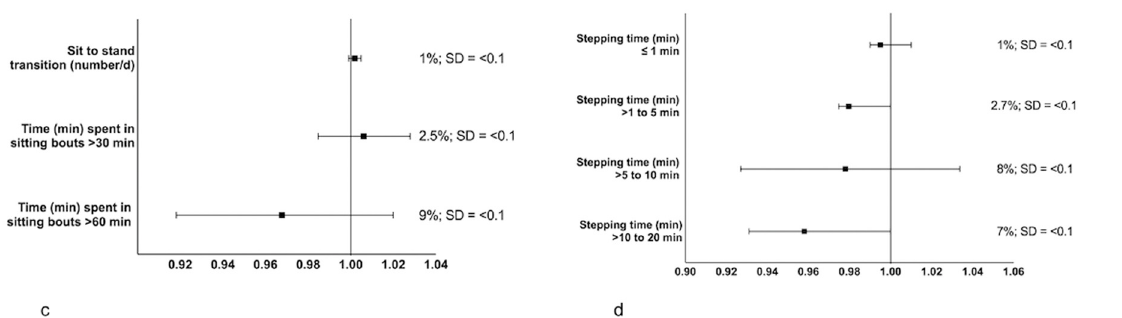
Figure 1. Equivalence of outcomes provided from the CREA and GHLA algorithms for ( a ) device wear time, ( b ) posture outcomes, ( c ) sitting bouts, and ( d ) stepping bouts. The solid squares represent the mean difference, whereas the horizontal lines show the 95% CI. To the right of each figure, the absolute zone needed to reach equivalence is provided as a %, alongside the zone necessary to achieve equivalence as a proportion of the SD. Outcomes from the CREA algorithm were used as the reference in all analyses and are presented here. All equivalence testing was repeated using the GHLA algorithm outcomes as the reference and provided identical results (not presented). An equivalence test not undertaken for stepping time > 20 min as only 13 cases provided values with the remaining comparisons all being zeros.